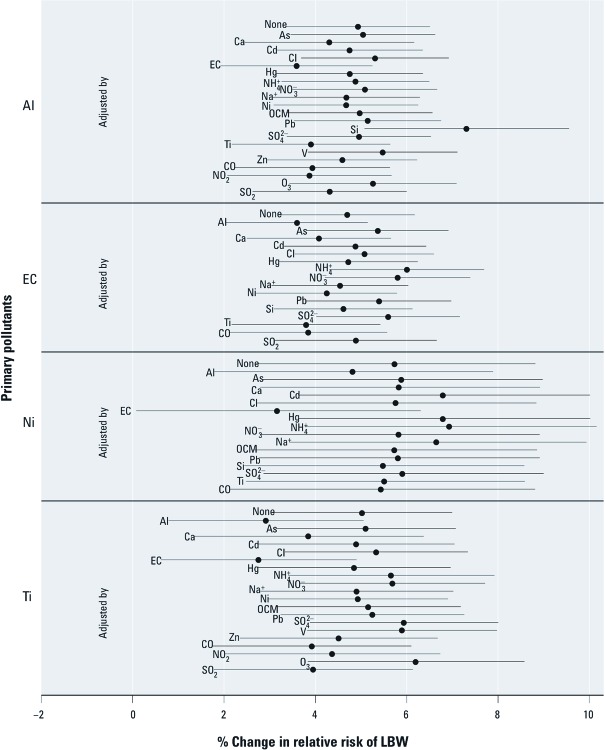
Percent change in relative risk of LBW per IQR increment in selected pollutants for gestational exposure with single (labeled as “None”) and two-pollutant (including the pollutant listed to the left of the estimates plus the pollutant indicated next to each estimate) logistic regression models. The point represents the central estimate and the horizontal line represents the 95% CI. See Table 4 for abbreviations.